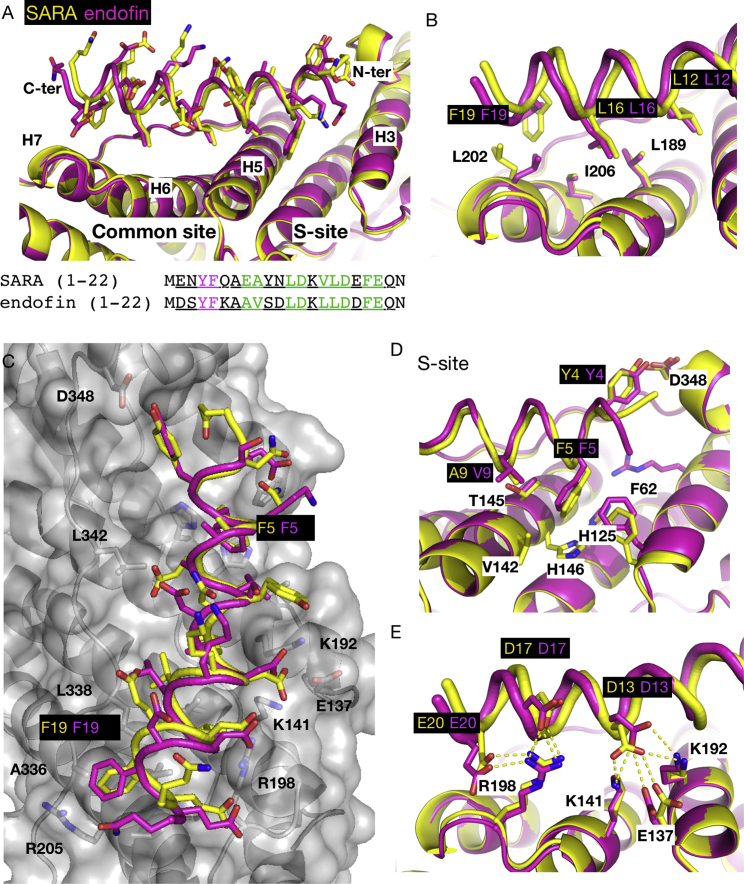
Analysis of the Interface of HD-PTPBro1 with SARA and Endofin(A) Ribbon representation of the structures of the HD-PTPBro1-SARA (yellow) and HD-PTPBro1-endofin (fuschia) complexes. The binding interface is extensive and covers the common CHMP4 binding site and a unique specific S site. Helices in the binding site are labeled. Below are the sequences of both peptides used in the crystallization where residues visible in the structures are underlined, residues that form interactions at the common site are in green, and those that bind to the S site are in magenta.(B) Detail of the HD-PTPBro1-SARA/endofin interface at the common site, showing the interaction of the conserved L12, L16, and F19 residues from SARA/endofin (color labels on black background) with the critical L202/I206 (Doyotte et al., 2008) and L189 residues from HD-PTPBro1 (black labels).(C) Surface representation of HD-PTPBro1-SARA structure with the SARA/endofin peptides superimposed. Labeled in black are the HD-PTPBro1 residues involved in interactions with the peptides at the C-terminal region (left side) and the common site (right side) of the Bro1 domain, labeled in black. The two conserved Phe residues in SARA/endofin are labeled according to the color code of each peptide.(D) Detail into the S site showing all residues involved in interactions. Color scheme as in (B).(E) Detail of the electrostatic interactions between basic residues in HD-PTP and the acidic residues in SARA/endofin. Color scheme as in (B).